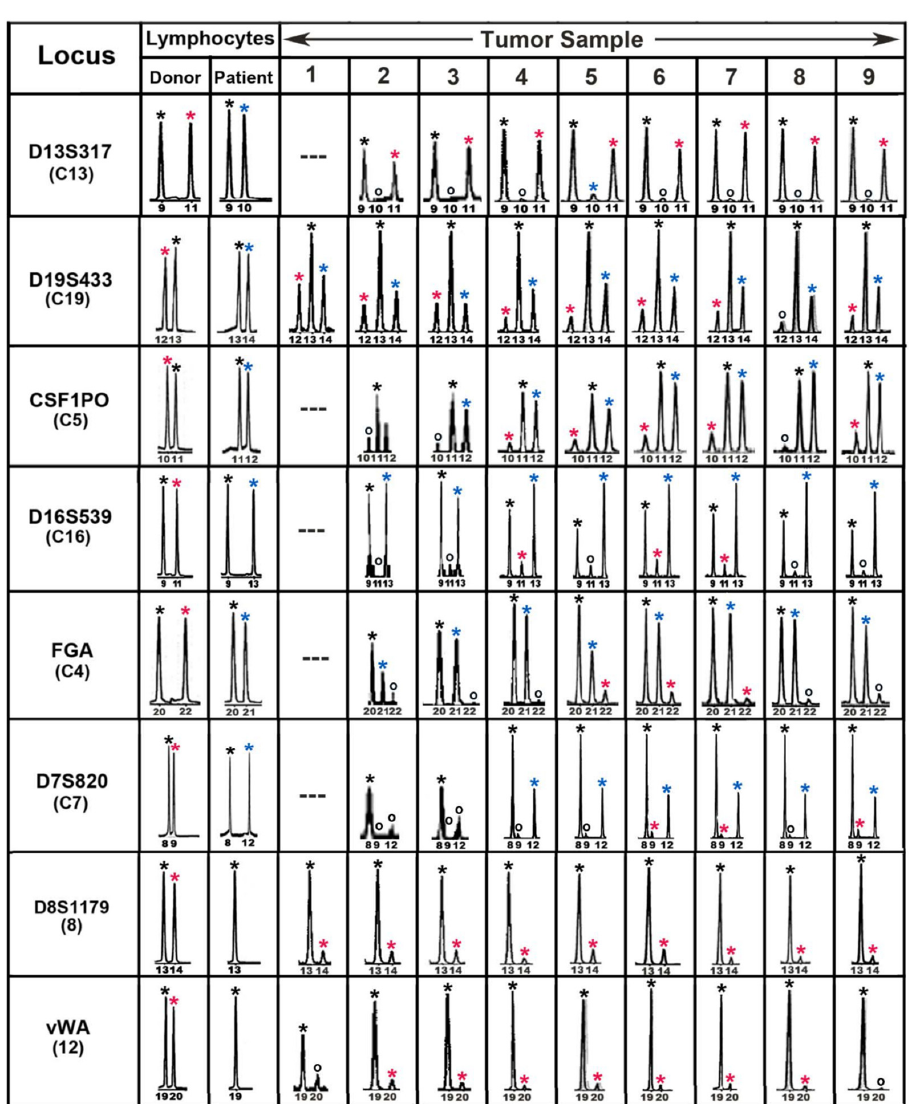
Figure 2. Forensic STR analyses of the MH3 melanoma along with donor and patient pre-BMT lymphocytes. Shown are “informative” loci exhibiting donor- and patient-specific alleles in pre-BMT lymphocytes. Tumor loci are listed in order of relative abundance of the donor-specific alleles (red asterisk) compared to patient-specific (blue asterisk) and shared alleles (black asterisk). Allele peaks, 50 relative fluorescence units were censored as “no call” (open circles). Loci with no detectable alleles after PCR amplification (—)